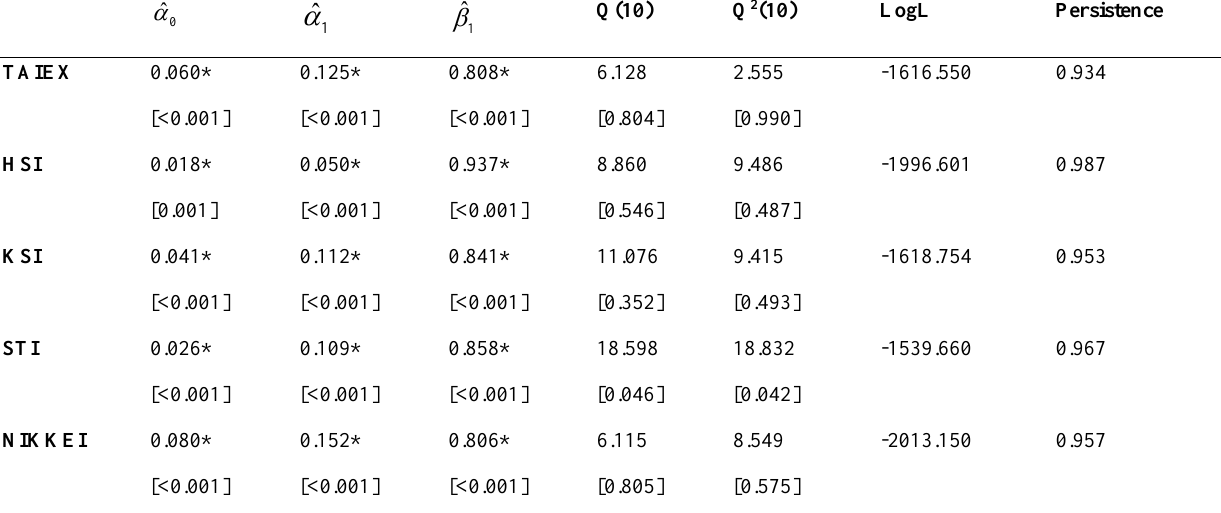
Table 5: The GARCH(1,1) model